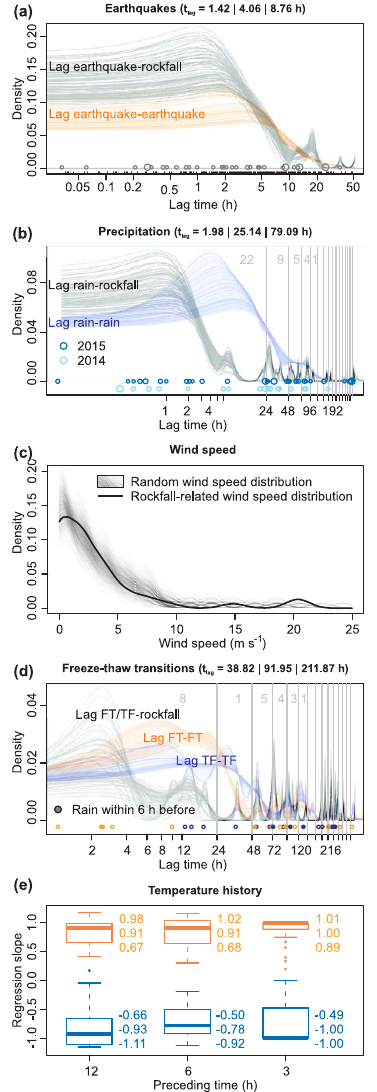
Figure 7. Time lags of all detected rockfall events to different po- tential triggers as shown by kernel density estimates based on sub- sampling the rockfall data set and using different kernel sizes. Val- ues in brackets in titles denote 25, 50 and 75 percentiles of the lag times. (a) Earthquakes. Lag times are of the order of lag times be- tween earthquakes (thick black line). The circle size is proportional to the seismic energy of the earthquake signal envelopes. (b) Pre- cipitation. Circle size proportional to cumulative rain amount of a preceding event. Circle colour depicts year. (c) Wind speed. The thick black line depicts the wind speed distribution during rock- fall events, and grey lines show distributions of randomly selected wind speed samples. (d) Freeze–thaw events. Circle colour indi- cates freeze–thaw (orange) versus thaw–freeze (blue) transitions. Filled circles indicate combination with rainfall within 6h. (e) Tem- perature history before an event illustrated as slope coefficients of linear regression lines of normalised air temperatures 3, 6 and 12h before a rockfall event. Positive (orange) and negative (blue) slopes are separated by colour. The values next to the box plots denote